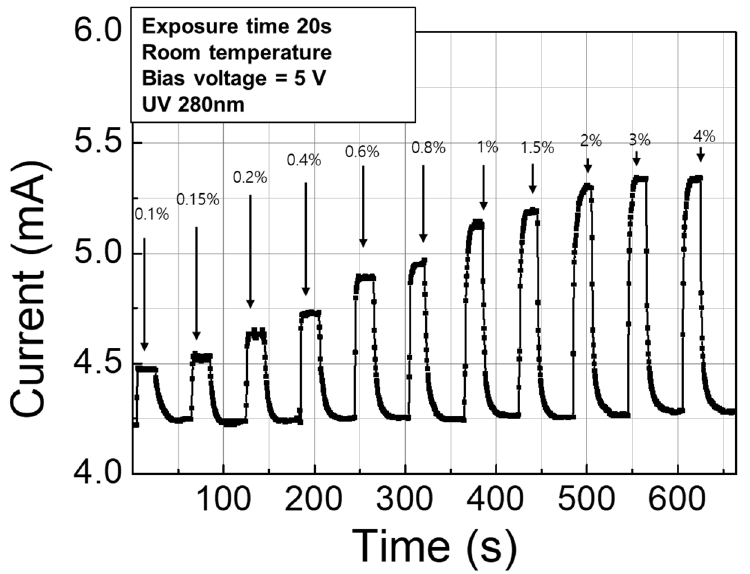
Figure 9. Hydrogen concentration dependent response characteristics of AlGaN/GaN hydrogen sensor at room temperature with UV illumination.